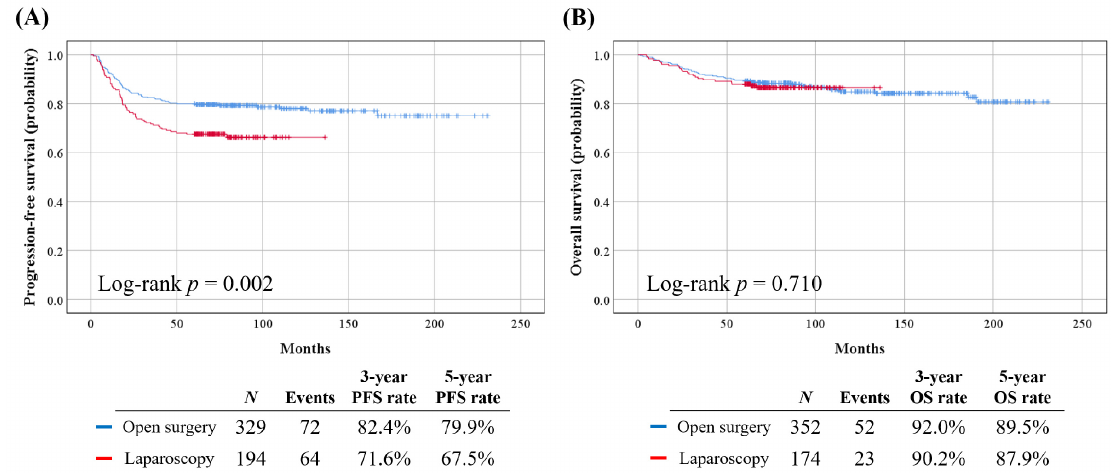
Figure 3. Comparisons of survival outcomes between the LRH and ORH groups in the PFS and OS sets: ( A ) PFS; ( B ) OS. Table 2. Summary of the selected variables using exhaustive variable selection